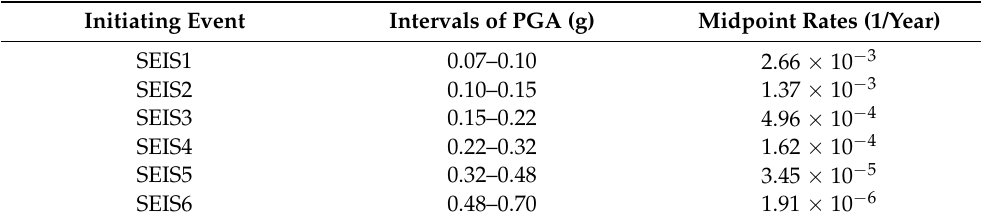
Figure 2. Seismic hazard curve.